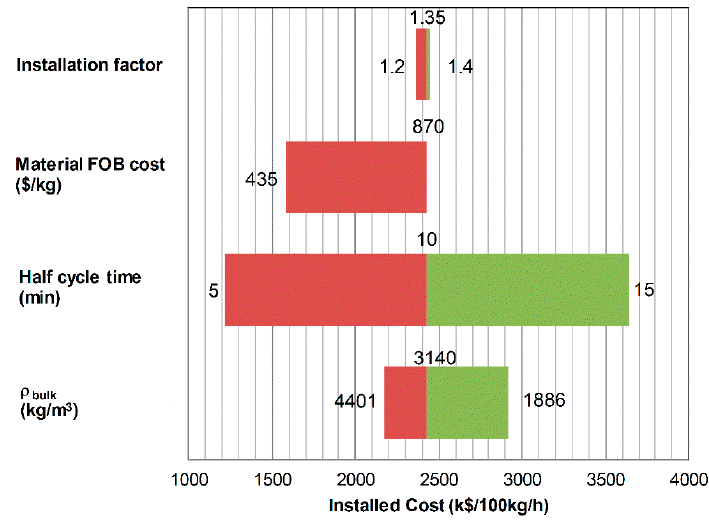
Figure 5. Tornado chart cost sensitivity for the large-scale (100 kg/h) HP2 system.